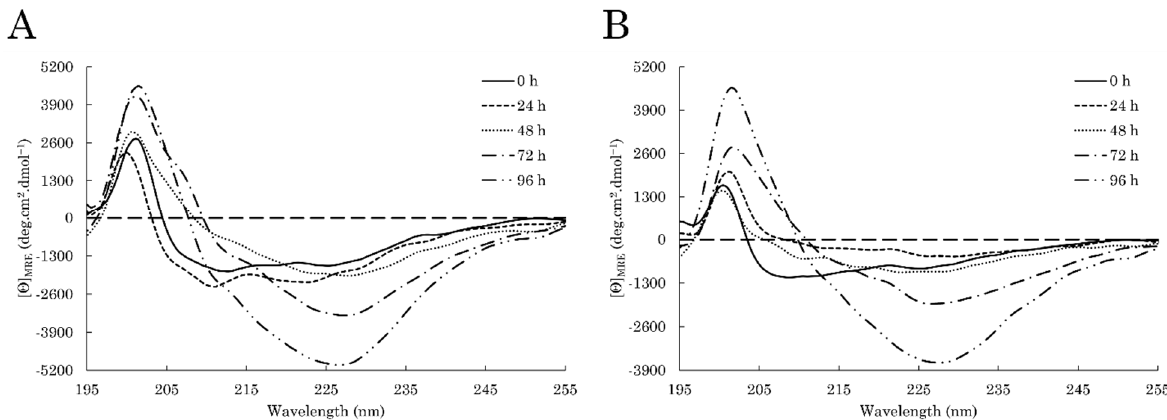
Figure 4. Far-UV CD spectra of ( A ) C-TERb and ( B ) C-TERa (C C-TER = 10 µ M) after 0 h (solid line), Figure 4. Far ‐ UV CD spectra of ( A ) C ‐ TERb and ( B ) C ‐ TERa (C C ‐ TER = 10 μ M) after 0 h (solid line), 24 24 h (dashed line), 48 h (dotted line), 72 h (dashed-dotted line), and 96 h (dashed-double-dotted line) h (dashed line), 48 h (dotted line), 72 h (dashed ‐ dotted line), and 96 h (dashed ‐ double ‐ dotted line) of incubation in TBS at ~20 ◦ of incubation in TBS at ~20 °C.